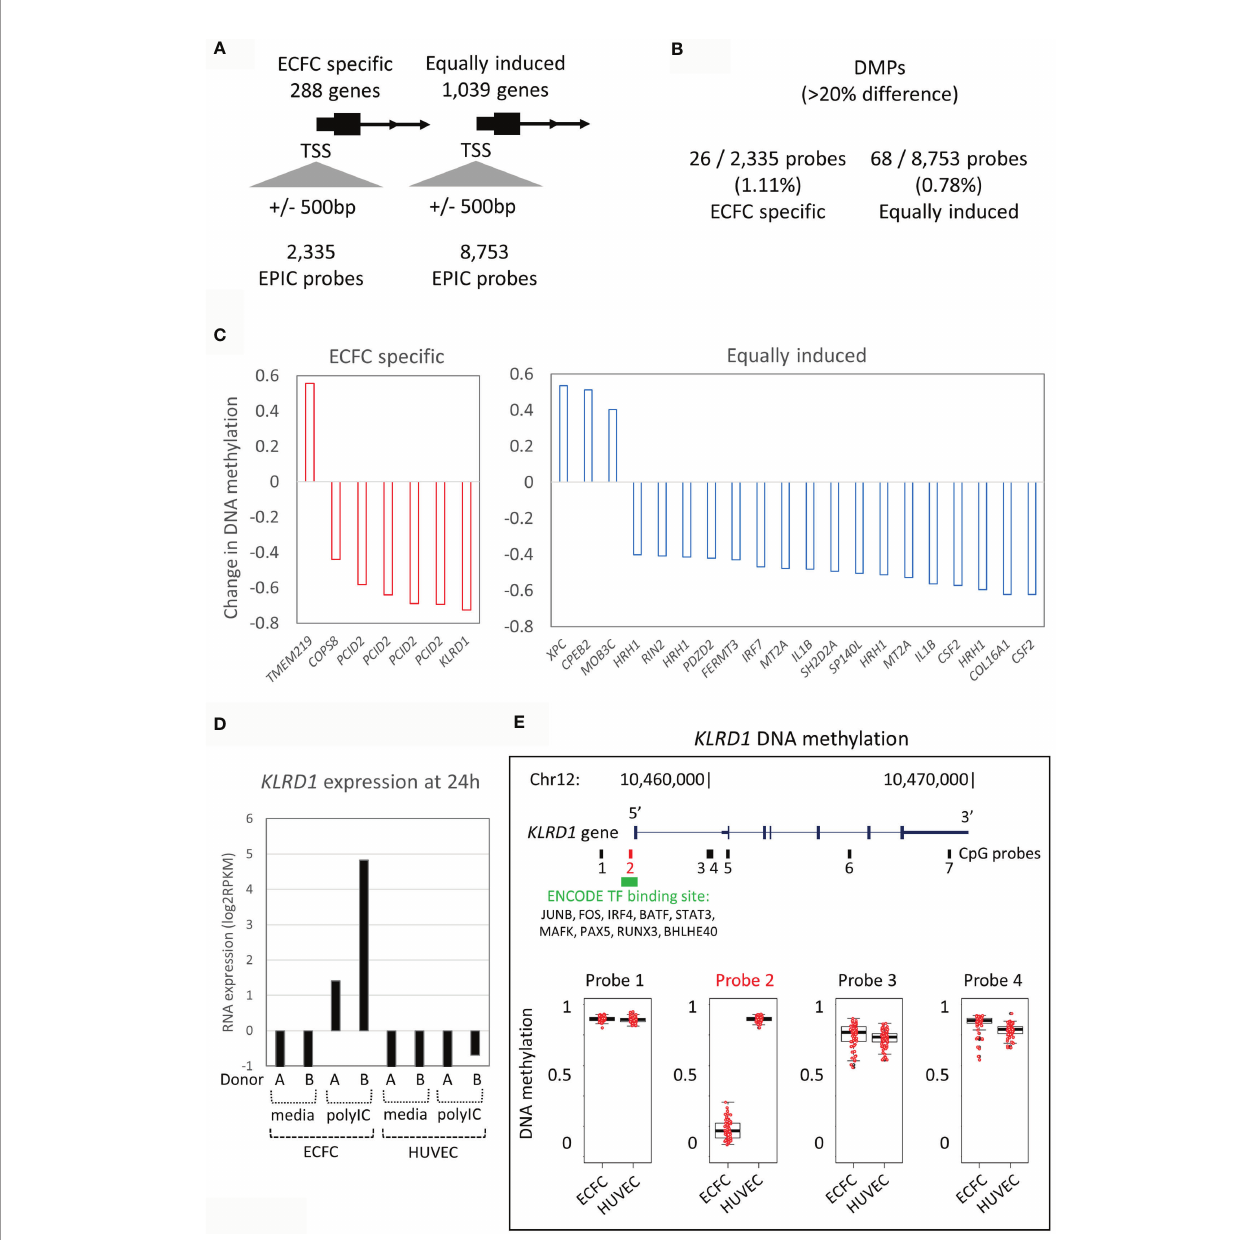
FIGURE 3 | DNA methylation patterns at promoters of Poly(I:C) induced genes. (A) The 288 ECFC-speci fi c Poly(I:C) induced genes have 2,335 EPIC probes at their promoters, while the 1,039 equally induced genes have 8,753 EPIC probes. (B) Only 1.1% and 0.8% of probes are differentially methylated (DMPs) between ECFCs and HUVECs. (C) Bar plot showing mean difference in DNA methylation between ECFCs and HUVECs at top promoter DMPs. (D) Bar plot showing expression of KLRD1 in ECFCs and HUVECs after 24h exposure to media or Poly(I:C). (E) Map of the KLRD1 locus, showing EPIC probes and TF binding tracks. Of the 7 EPIC probes, only one is differentially methylated between ECFCs and HUVECs. Probe 2 is present at the transcriptional start site (TSS), overlaps TF binding sites and shows complete hypomethylation in ECFCs, predicting